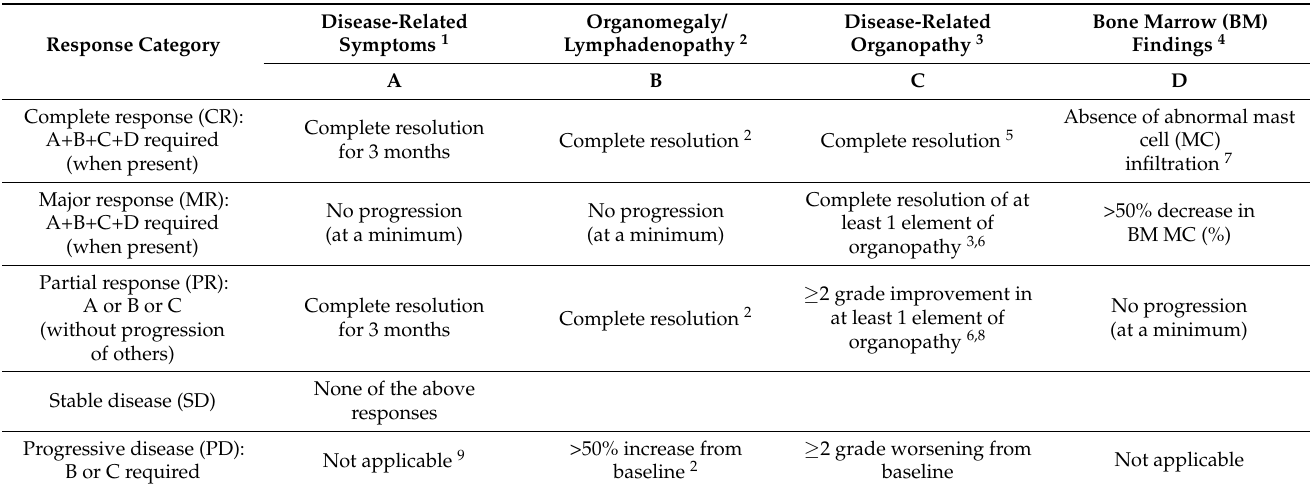
Table 2. Mayo Clinic revised response criteria in